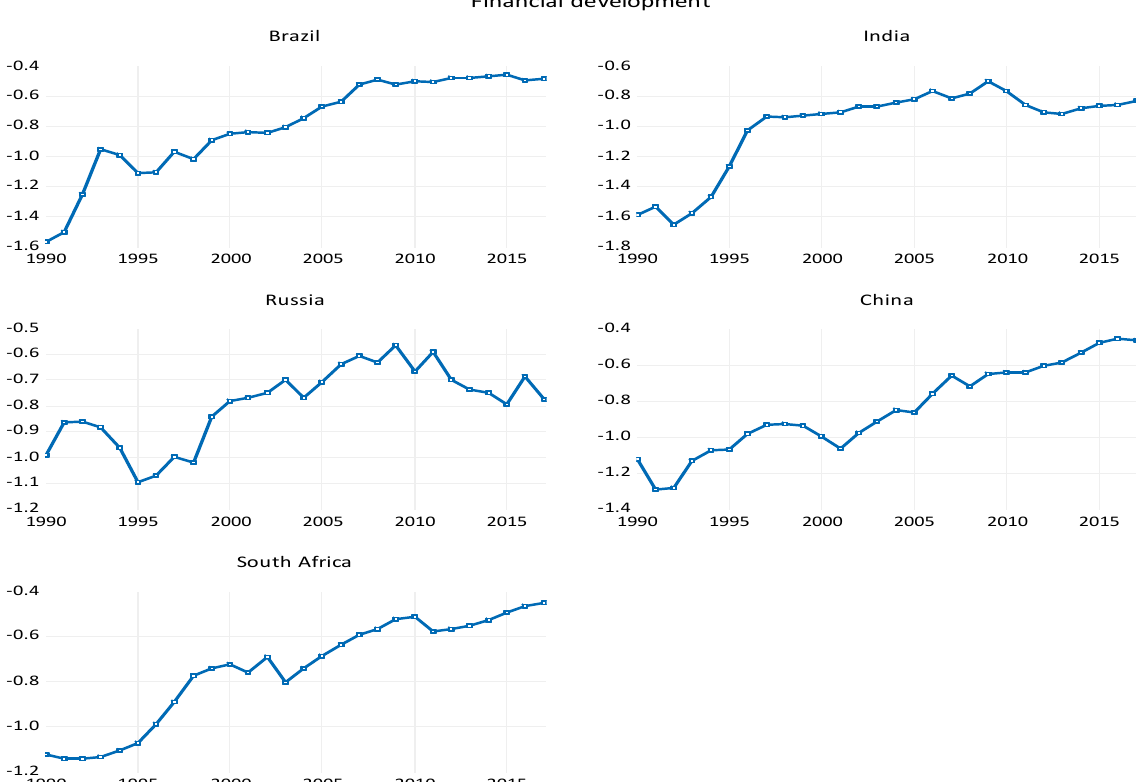
Figure 2. Trends in financial development in BRICS countries.